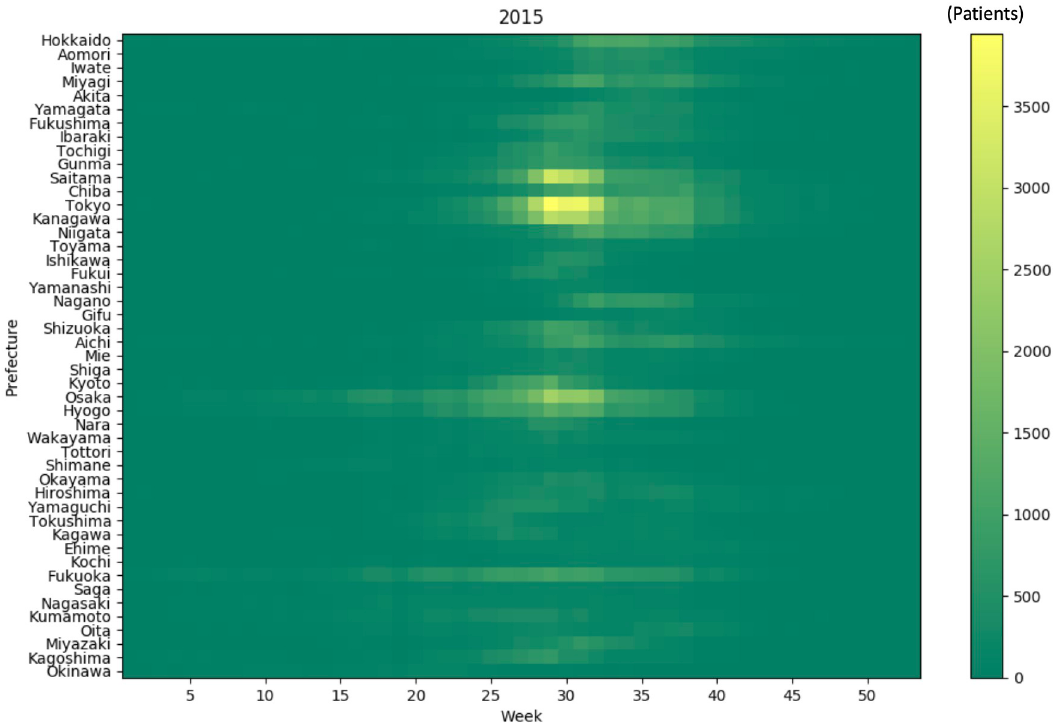
Fig 8. Heat map of the actual HFMD patient numbers in 2015. The actual patient numbers by prefecture were displayed.